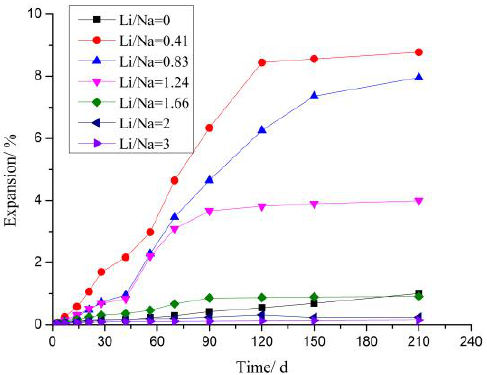
Figure 4. Expansion curves of rock prisms cured in different alkaline solutions at 80 ℃ .